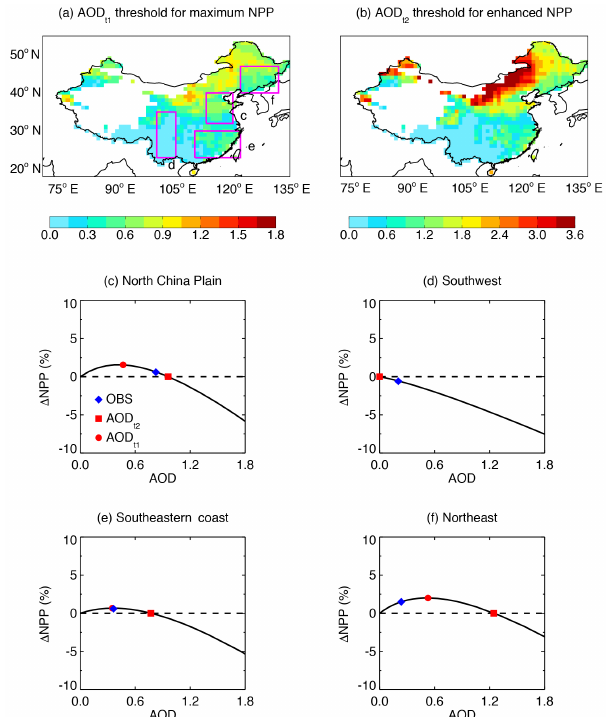
Figure 6. Thresholds of AOD at 550nm for aerosol DFE. (a) AOD t1 threshold leading to maximum NPP in summer (June– August). (b) AOD t2 threshold leading to enhanced summer NPP. Aerosol indirect effects and climatic feedback are not included for these thresholds. The average AOD-NPP response curves at four box domains in (a) are shown in (c) – (f) , with red symbols indicating two AOD thresholds and blue symbols indicating observed AOD from MODIS. Chinese regions with low aerosol-free NPP (<0.05 gCm − 2 day − 1 ) are blanked in (a) and (b) . The color scales for (a) and (b) are